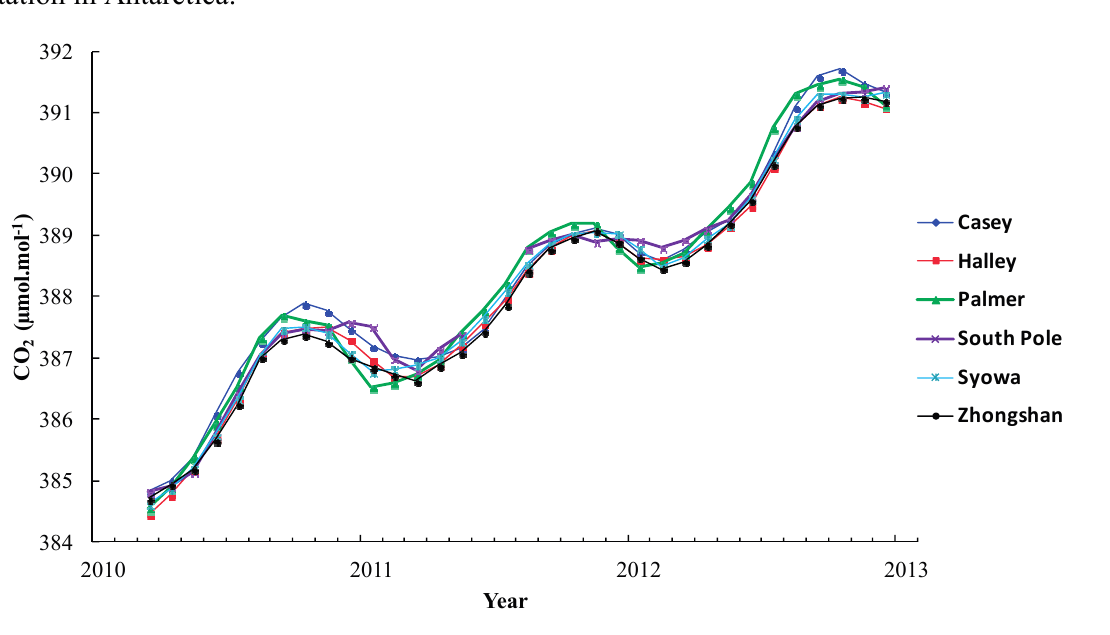
Figure 10. Time sequence of average monthly CO station in Antarctica.